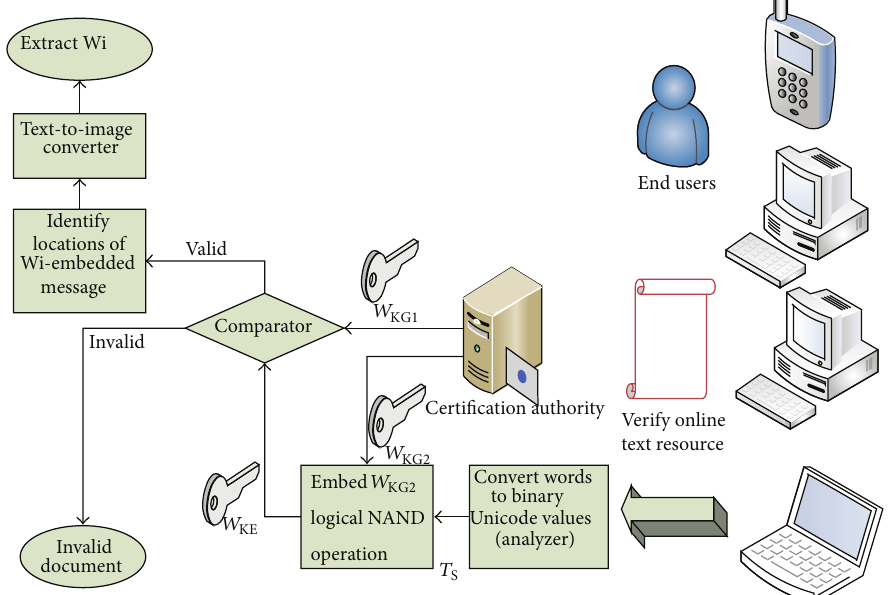
Figure 6: Watermark decoding